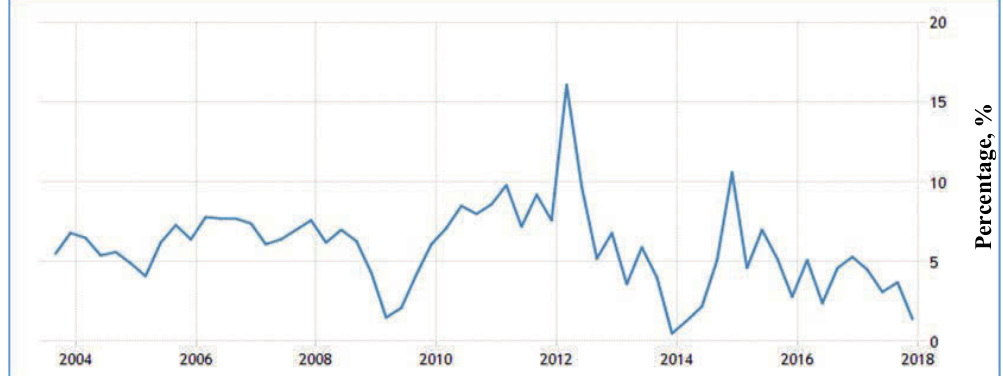
Fig. 1. Real GDP growth in Sri Lanka (Department of Census & Statistics, Sri Lanka,